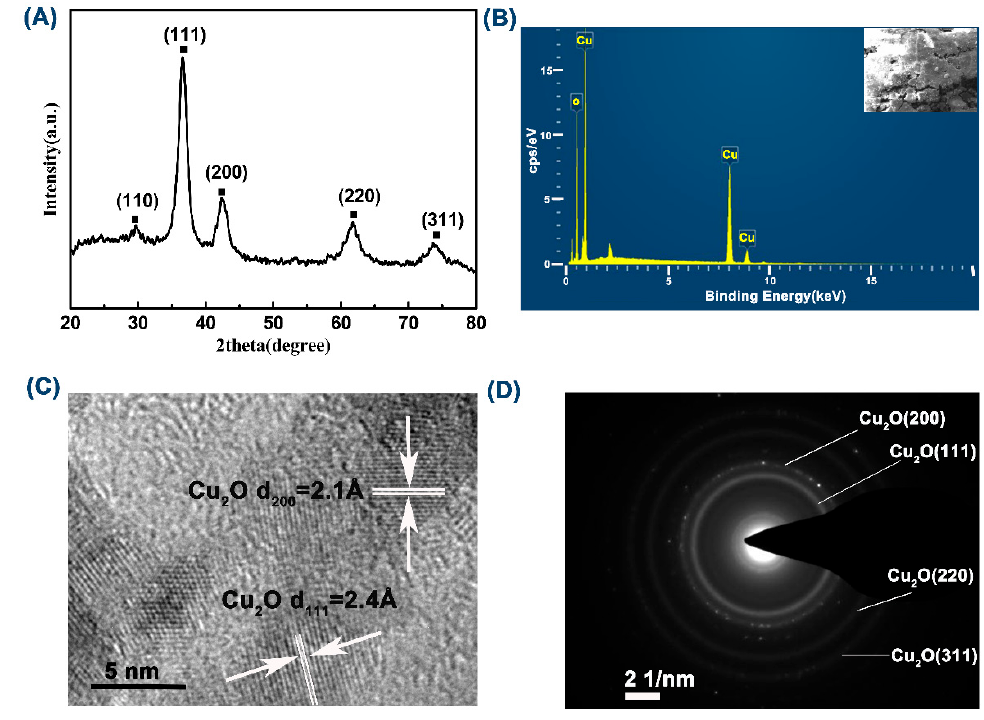
Figure 1. ( A ) X-ray diffraction (XRD) pattern of the prepared Cu 2 O; ( B ) EDX map of the prepared Cu 2 O; ( C ) high-resolution transmission electron microscopy (HRTEM) image of the prepared Cu 2 O; ( D ) selected area electron diffraction image of the prepared Cu 2 O.